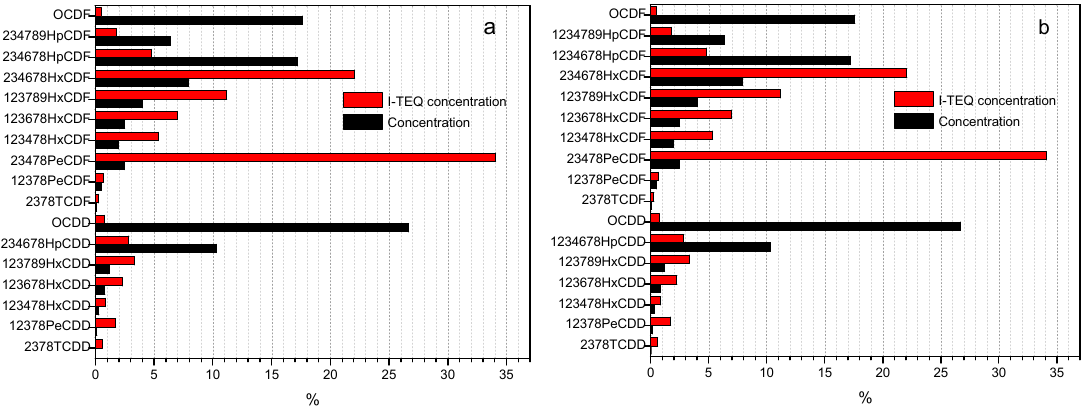
Figure 7. Ploychlorinated dibenzo ‐ p ‐ dioxins and dibenzofurans (PCDD/Fs) toxic congener pattern in APC residues ( a ) raw APC residue; ( b ) residue after washing twice).